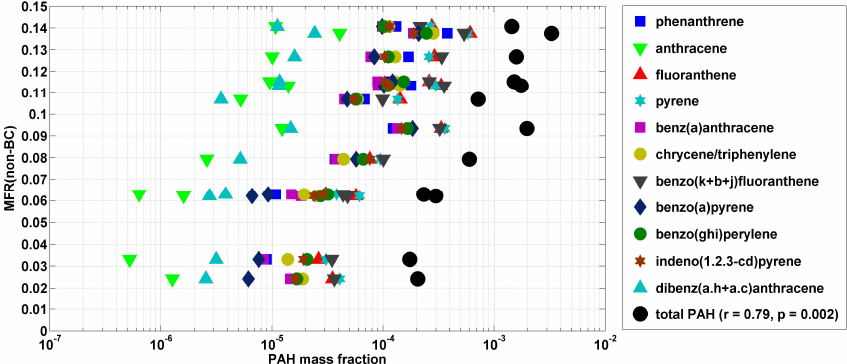
Fig. 8. Aerosol mass fraction remaining (MFR non-BC ) at 280 ◦ C as a function maximum mass fractions of PAHs. Monthly means have been used. Note the logarithmic